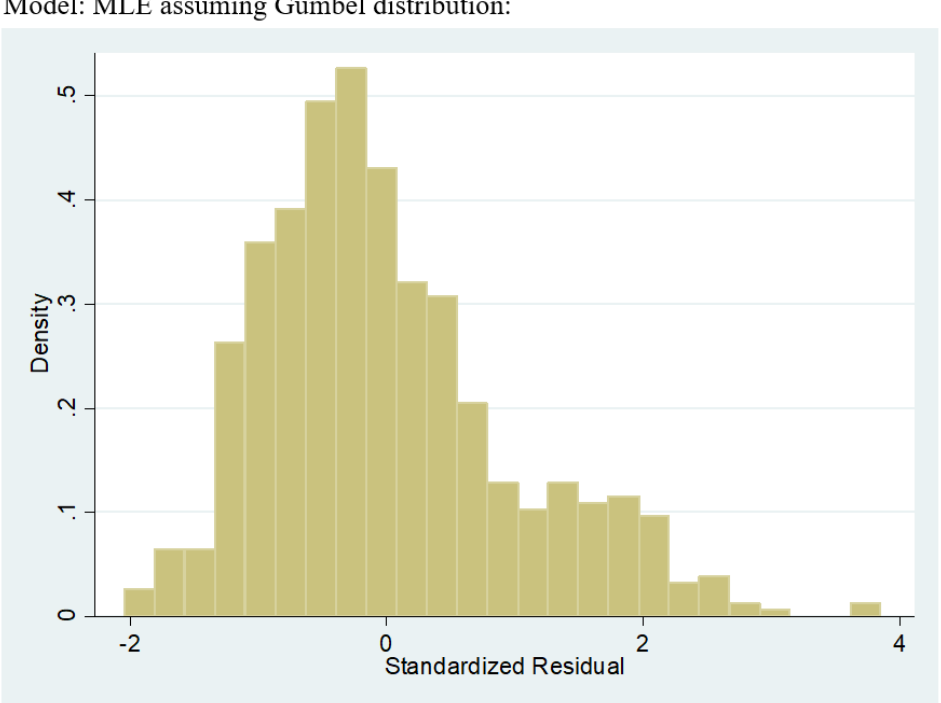
Figure A3. Histogram of the Standardized Residual from the Model for Annual Total Expenditures on Dental